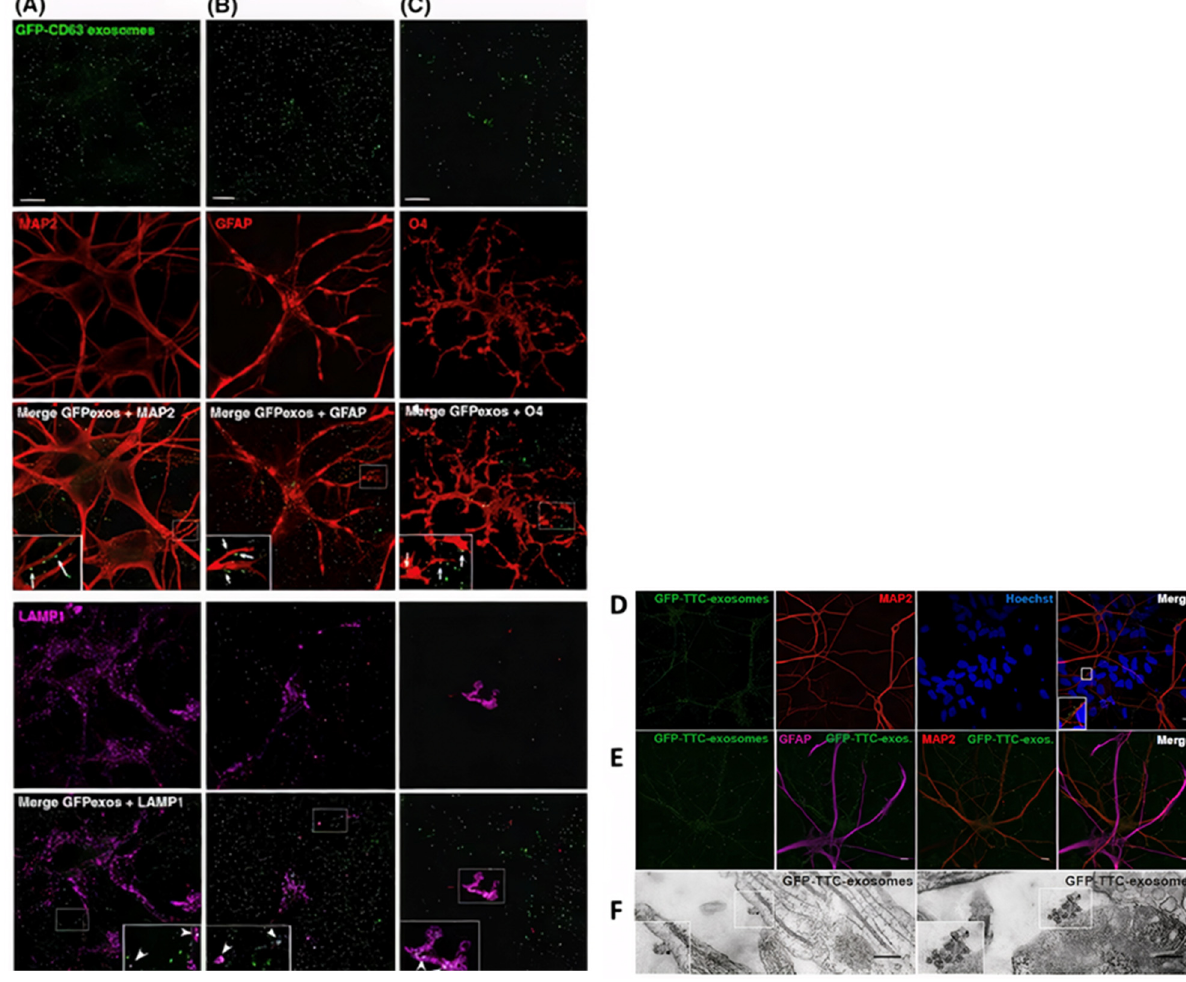
Figure 8. Neuroblastoma exosomes carrying GFP-CD63 bind to and are endocytosed by neurons and glial cells. ( A ) MAP2, ( B ) GFAP, and ( C ) O4 to label neurons, astrocytes, and oligodendrocytes, respectively, and with antibodies against Lamp-1 ( A – C ) to stain late endosomes and lysosomes. ( D – F ) Neuronal exosomes bearing GFP_TTC bind specifically to neurons [12]. Figure and caption reproduced with permission from John Wiley and Sons.